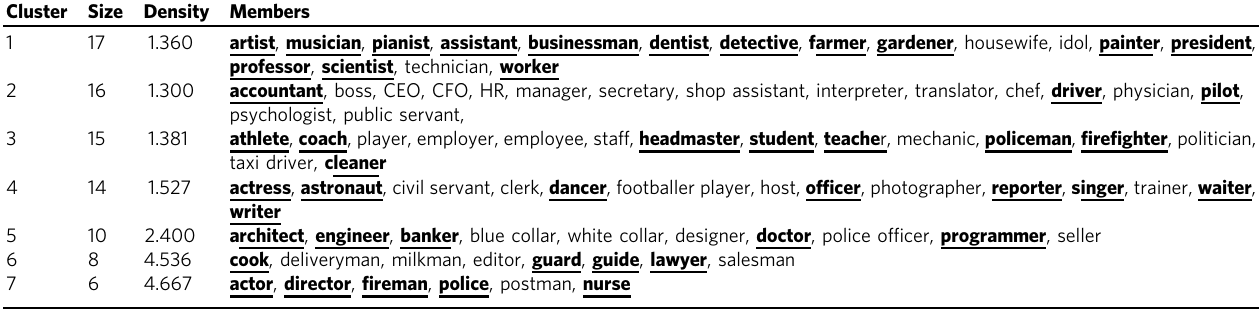
Bold and underlined words are shared by the two networks.